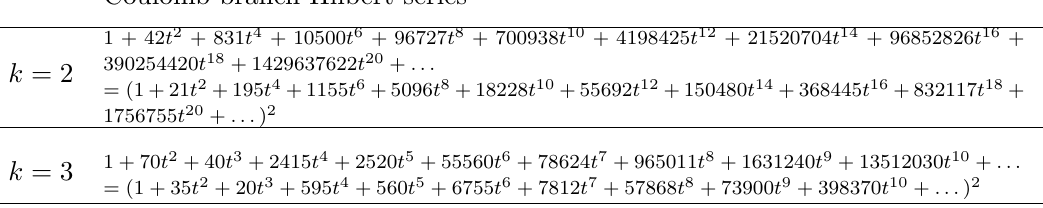
Table 23. Hilbert series results for (4.28). The first line displays the Coulomb branch Hilbert series for (4.28), while the second line displays the factorisation into a product of two identical factors. Each factor agrees with the known Hilbert